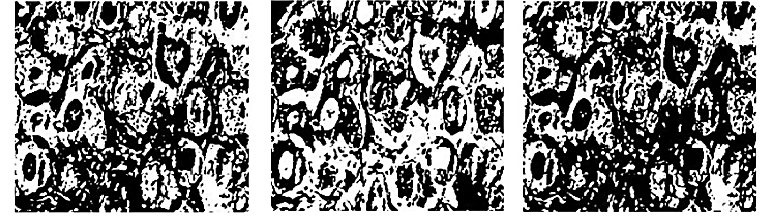
Figure 14. Comparison of result by segmentation and proposed segmentation